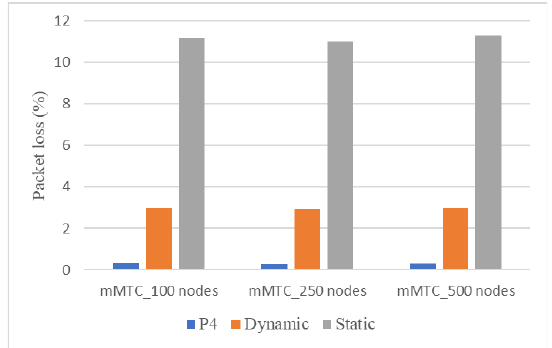
Figure 14. Average packet loss ratio in the URLLC slice.